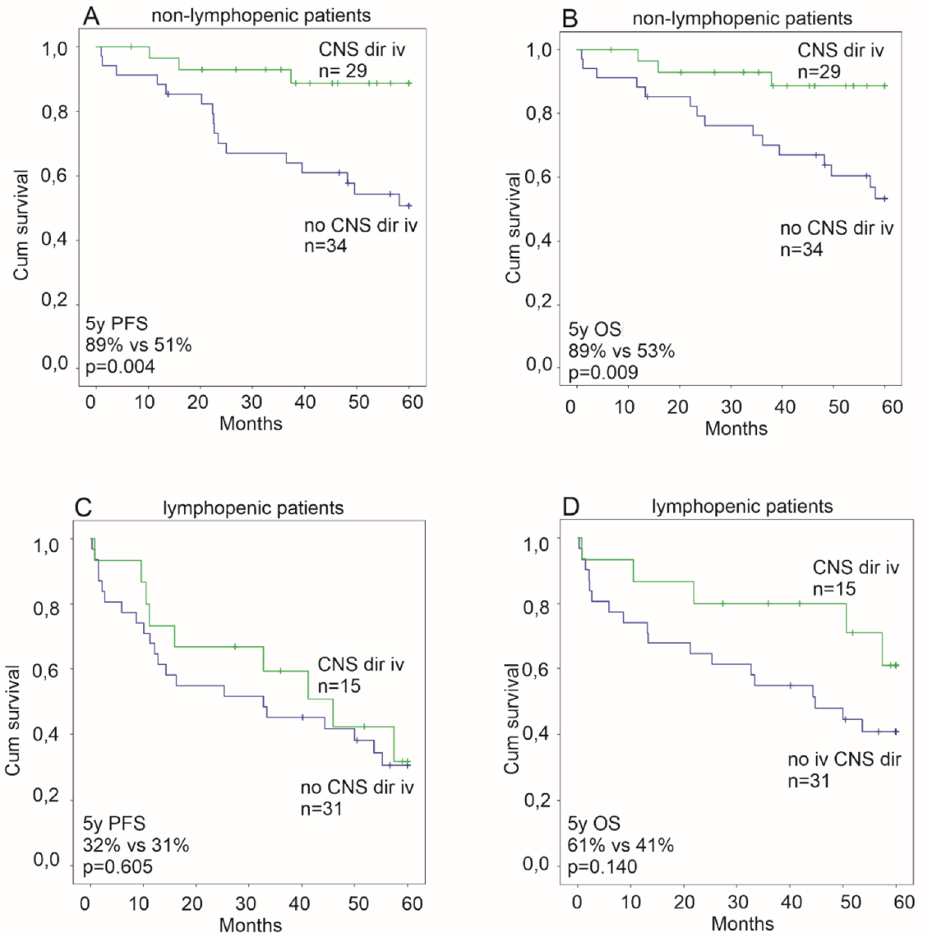
Figure 2. Kaplan-Meier estimates of the impact of intravenous (iv) central nervous system directed chemotherapy on survival among non-lymphopenic rituximab treated patients ( A , B ) and lymphopenic rituximab treated patients ( C , D ). An association to an improved progression free survival (PFS) and overall survival (OS) is seen only among non-lymphopenic patients ( A , B ).